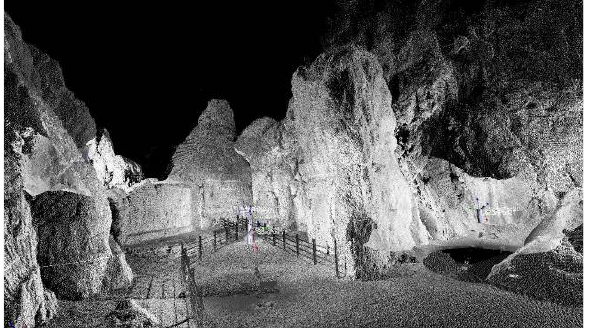
Figure 8. Point cloud of the Chamber A